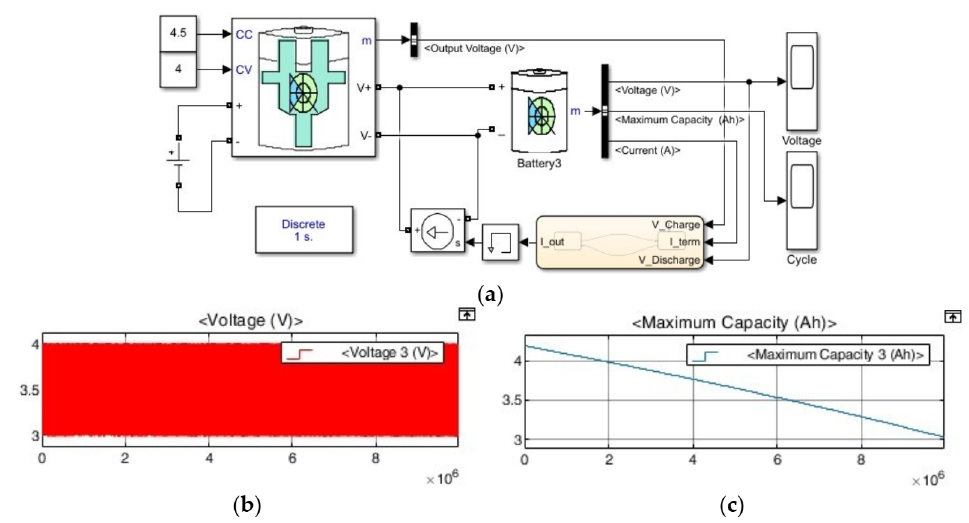
Figure 14. Comparative standard aging simulation. ( a ) Schematic. ( b ) Voltage result. ( c ) SOH result. Table 7. Aging progress when applying the proposed cell-balancing method.